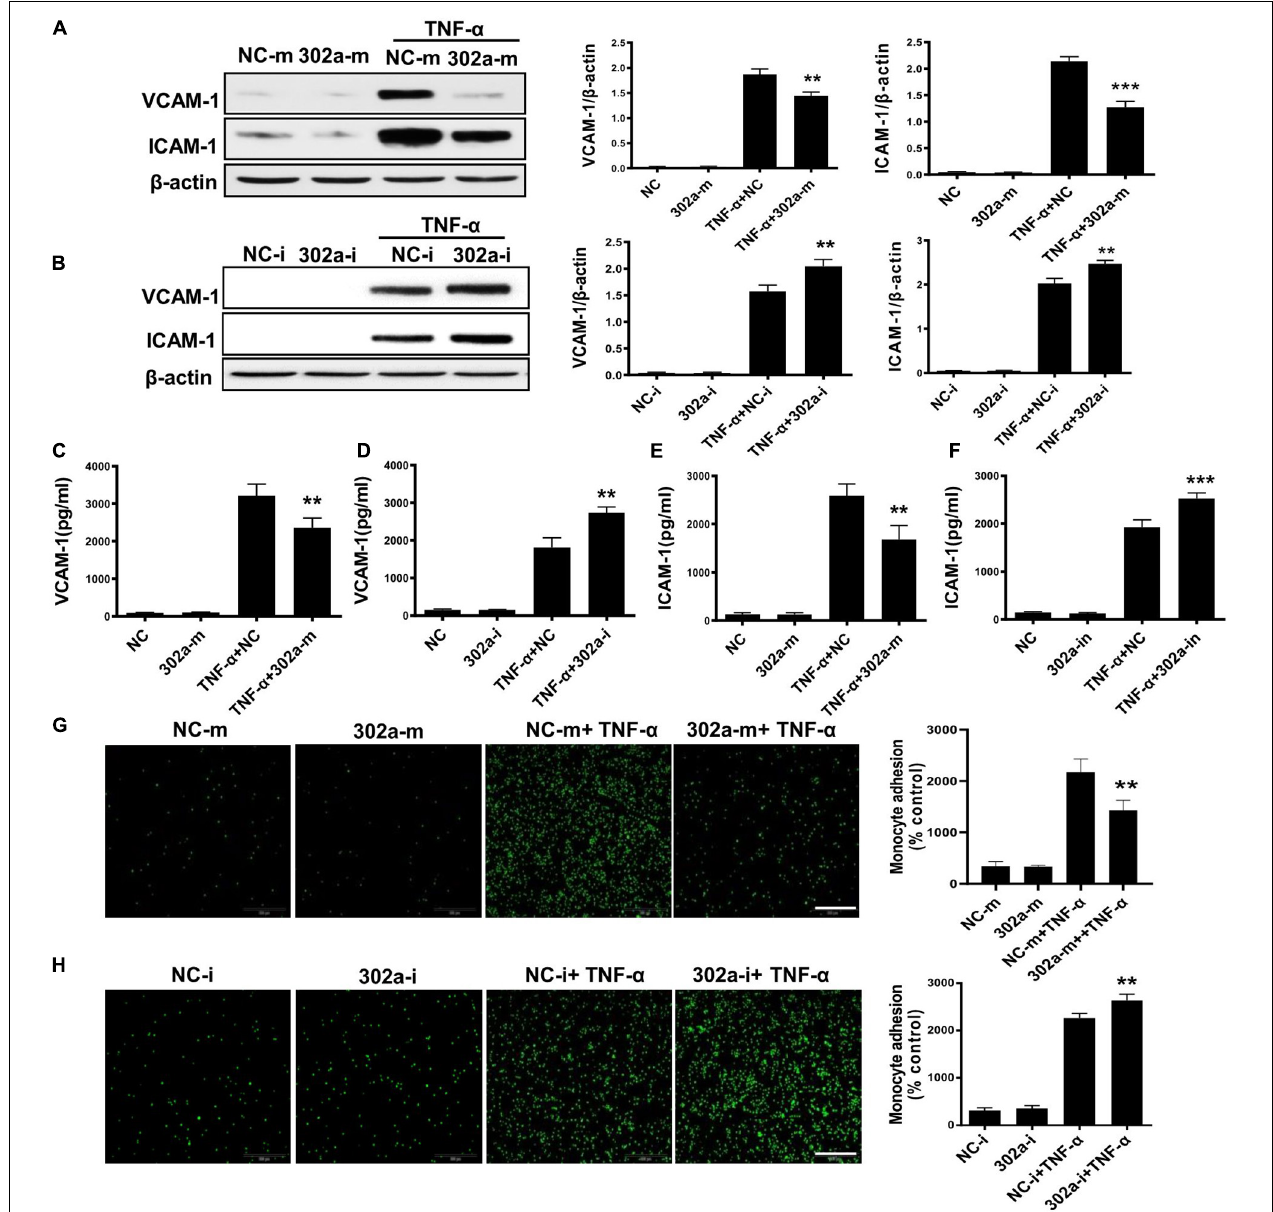
FIGURE 4 | MiR-302a inhibits secretion of adhesion factors and adhesion of monocytes to endothelial cells. (A) VCAM-1 and ICAM-1 protein levels in Human Umbilical Vein Cells (HUVECs) transfected with 25 nM miR-302a-mimics/NC-mimics after TNF- α (10 ng/ml) treatment for 12 h, n = 5. (B) VCAM-1 and ICAM-1 were detected by western blot in HUVECs transfected with 100 nM miR-302a-inhibitor/NC-inhibitor after TNF- α (10 ng/ml) treatment for 12 h. * p < 0.05; ** p < 0.01; *** p < 0.001 vs. TNF- α + NC, n = 5. The secretion of VCAM-1 (C) and ICAM-1 (D) in HUVECs culture medium detected by ELISA after transfected with miR-302a-mimics/NC-mimics (25 nM) for 36 h and then treated with 10 ng/ml TNF- α for 12 h. * p < 0.05; ** p < 0.01; *** p < 0.001 vs. TNF- α + NC, n = 5. The expression of VCAM-1 (E) and ICAM-1 (F) in HUVECs culture medium detected by ELISA after transfected with miR-302a-inhibitor/NC-inhibitor (100 nM) for 36 h and then treated with 10 ng/ml TNF- α for 12 h. * p < 0.05; ** p < 0.01; *** p < 0.001 vs. TNF- α + NC, n = 5. Representative photo images and quantification of calcein-labeled THP-1 monocytes adhering to TNF- α -activated HUVECs transfected with 25 nM miR-302a-mimics (G) or 100 nM miR-302a-inhibitor (H) (* p < 0.05; ** p < 0.01; *** p < 0.001 vs. TNF- α + NC; n = 5), scale bar, 200 µ